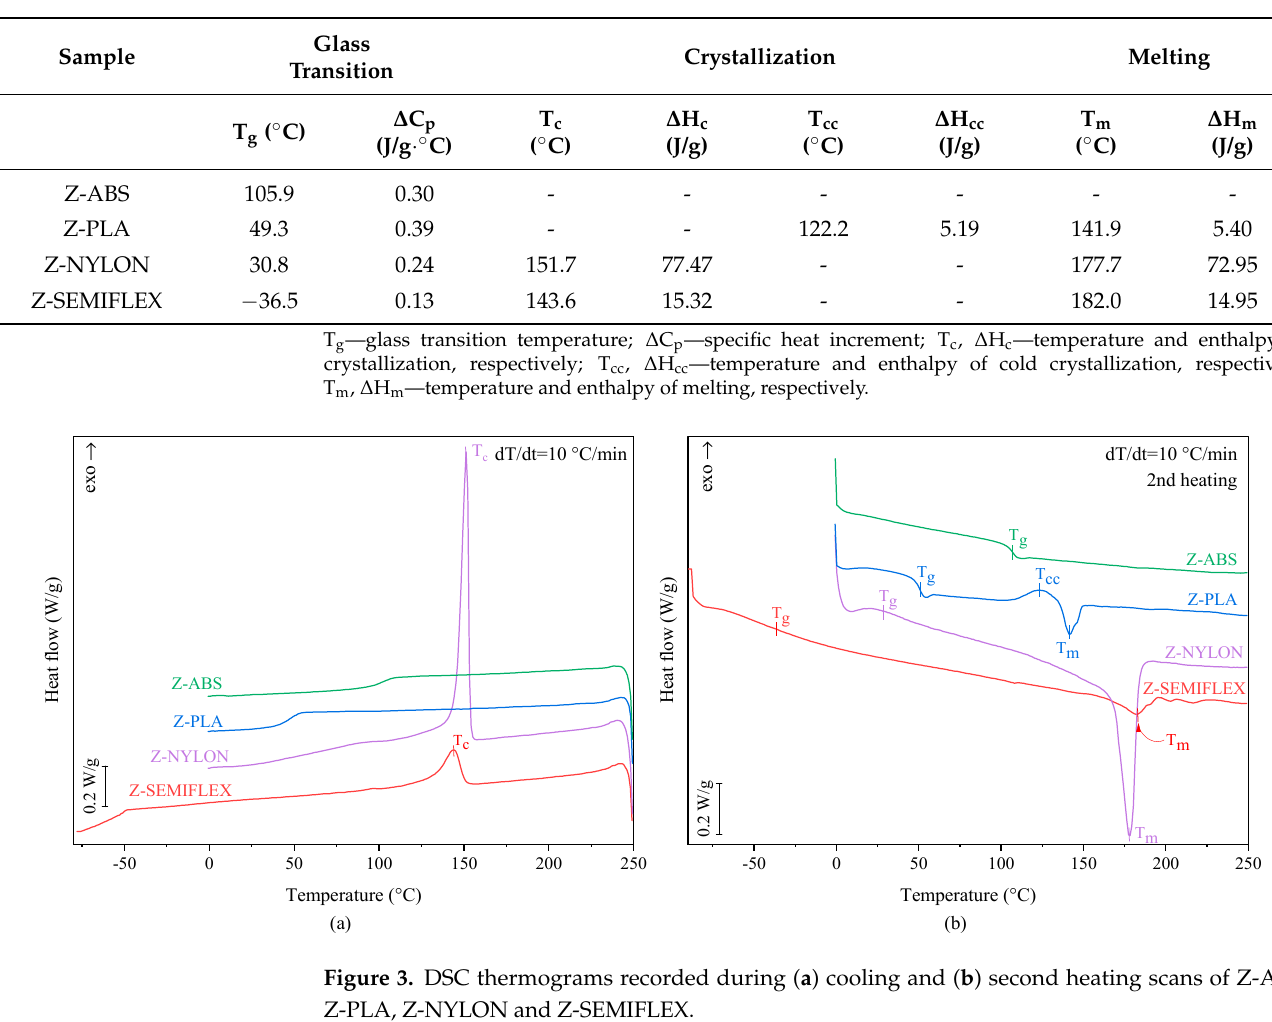
Table 4. Thermal properties of investigated samples.